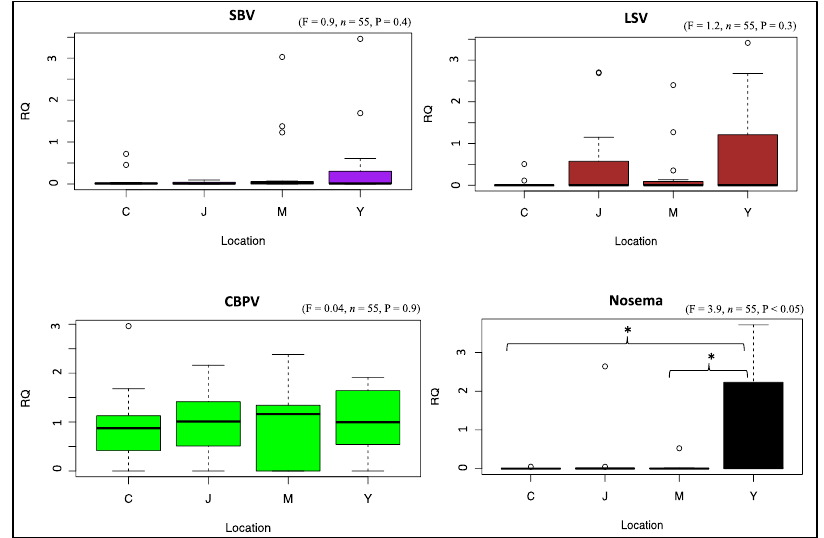
Figure 4. Relative quantification (RQ) of overall viral infections of the studied colonies exposed by location. Abbreviation codes are (C) Chickasaw, (J) Jackson, (M) Milan, and (Y) Yum-Yum. The Boxplots (aka, Box and whisker Plots) summarize the data distribution based on minimum, first quartile, median, third quartile and maximum values. Viruses are: sac brood virus (SBV), Lake Sinai virus (LSV), and chronic bee paralysis virus (CBPV). Levels of nosema are also given for colonies of each location. ANOVA signification levels are * p < 0.05.